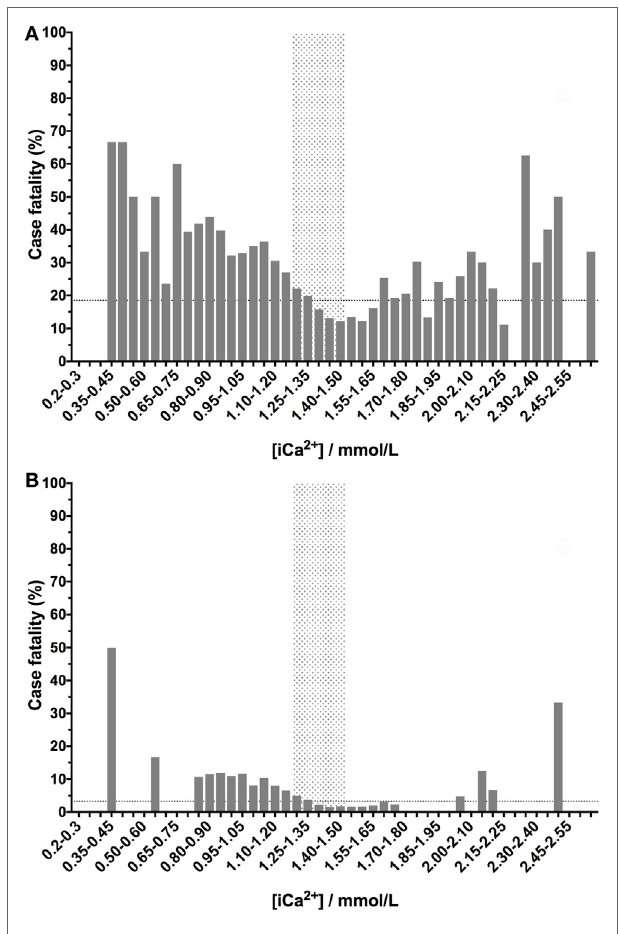
FigUre 4 | Canine ionized calcium concentrations have a U-shaped relationship with case fatality rates. Low- or high-ionized calcium concentrations are associated with increased case fatality rates. Ionized calcium values were banded into 0.05 mmol/L bins, and the percentage case fatality for the patients in each of these subgroups was calculated. The dotted lines denote the case fatality rate across the entire data set (the background case fatality rate). Panel (a) represents data from all samples ( n = 33,117), including those from patients that were euthanized, while panel (b) represents data from patients that survived or died only (i.e., euthanized patients were excluded) ( n = 27,904).